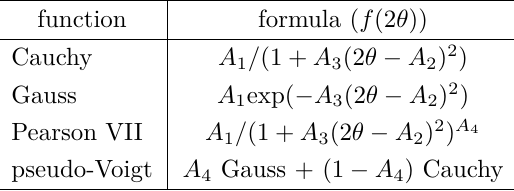
, angular 1 , the relative width A 2 3 4